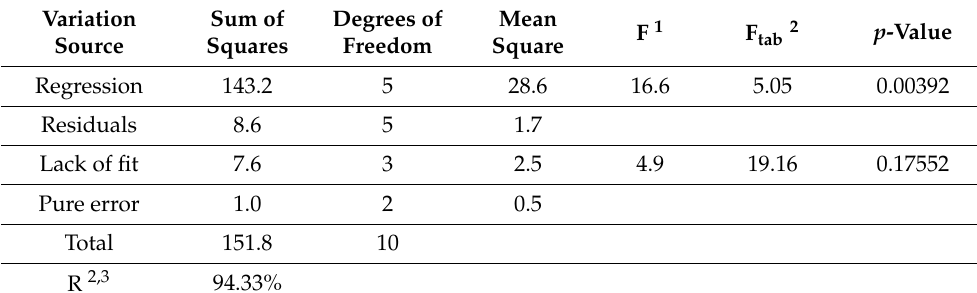
Table 2. Analysis of variance (ANOVA) of the predictive model for the clove extract loading in PC.